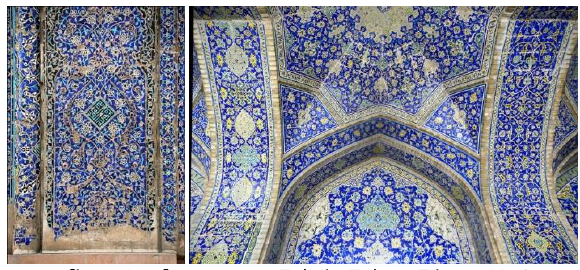
figure 9. Blue Mosque, Tabriz, Tehran Times, 2016